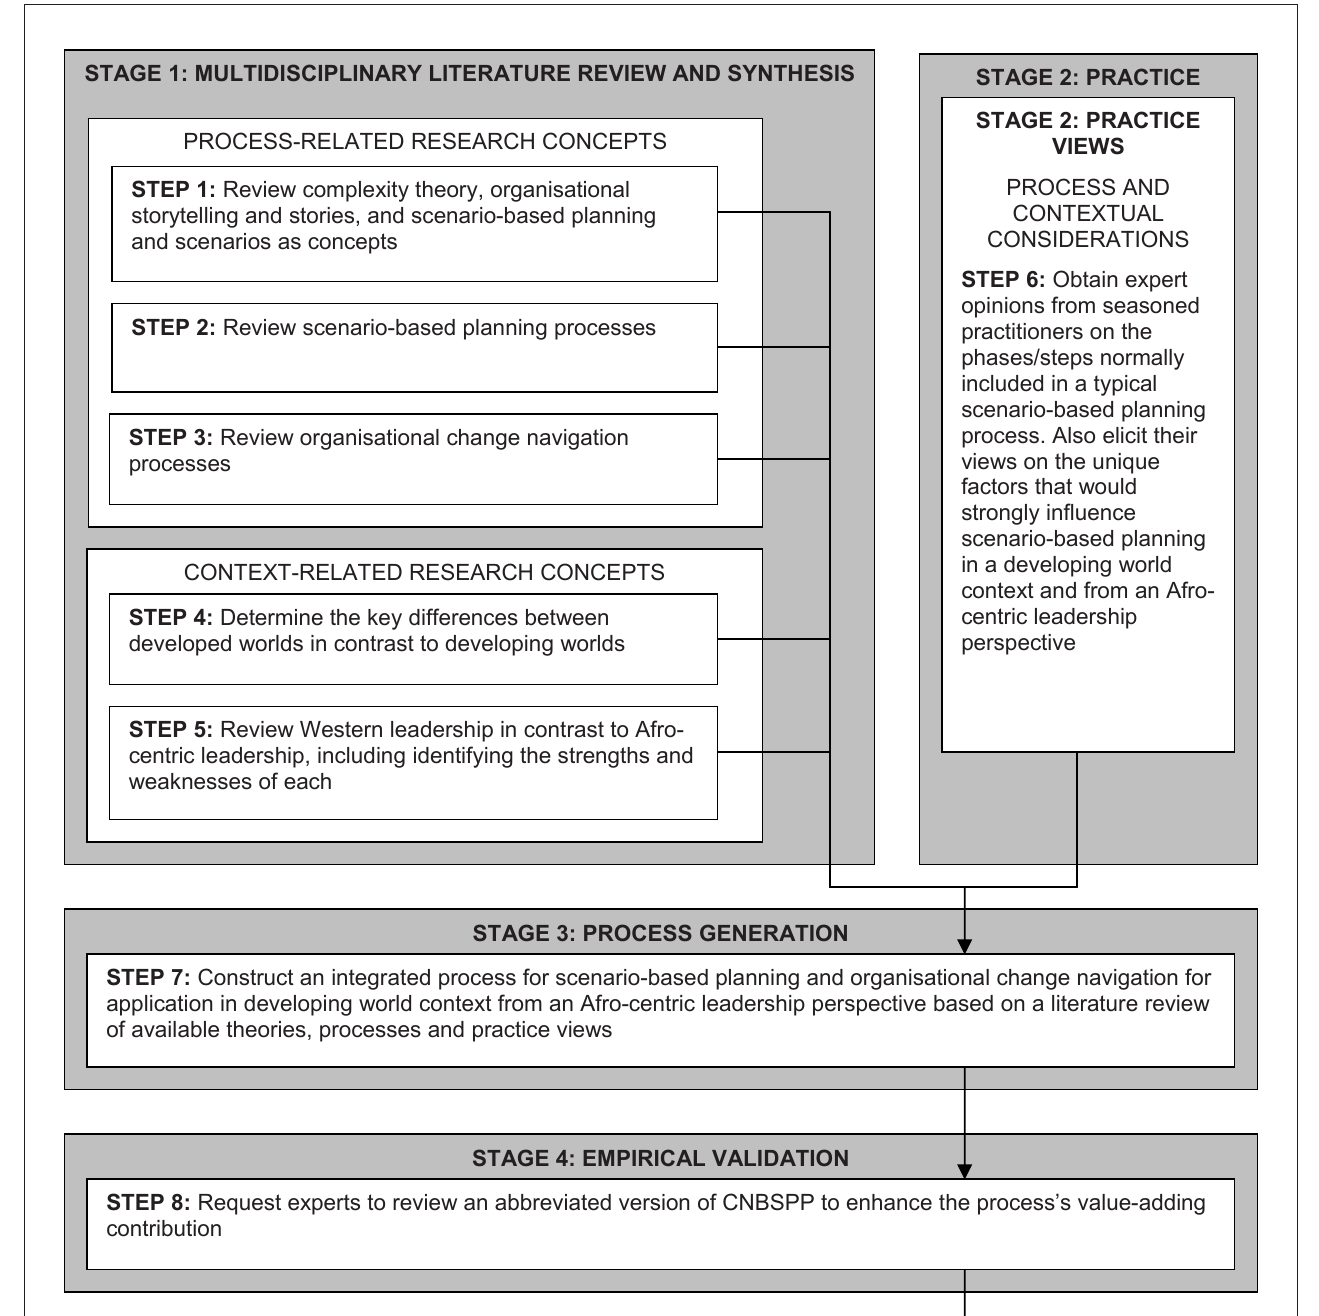
Figure 1: Schematic illustration of the research process to be